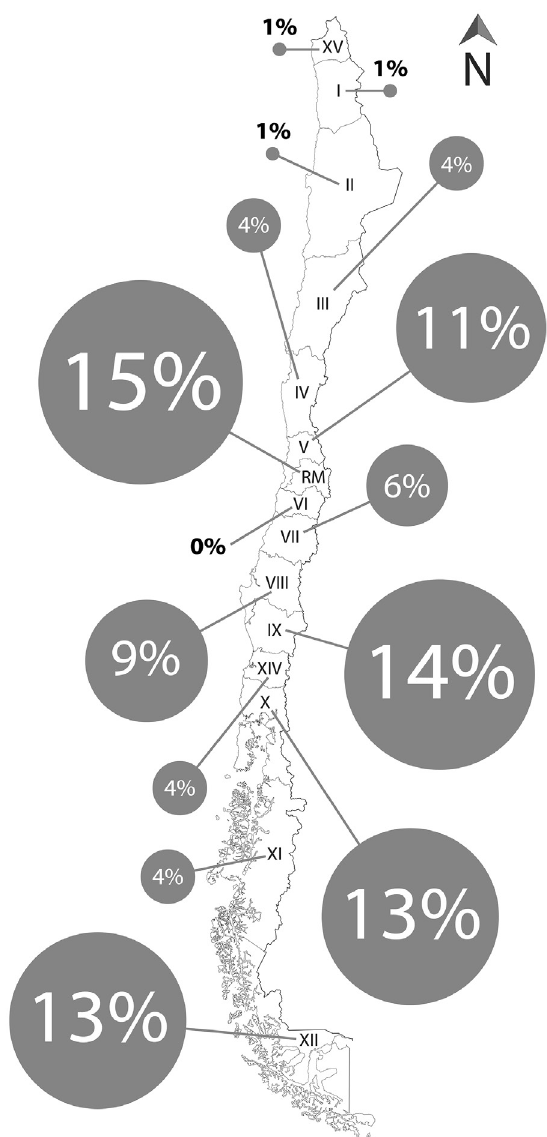
Figure 3. Relative abundance of studies published for each administrative region of Chile.